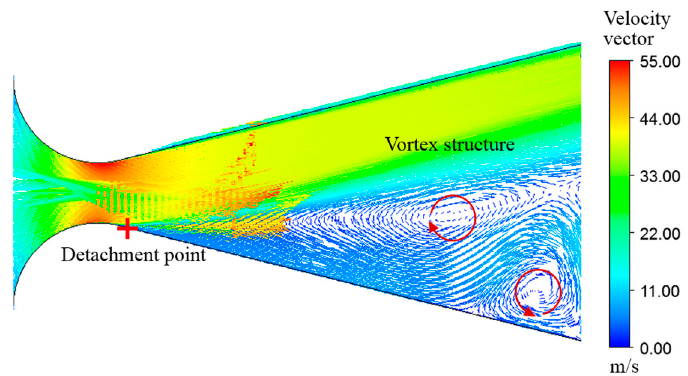
Figure 7. Velocity field in the unvaned diffuser (steady flow simulation).